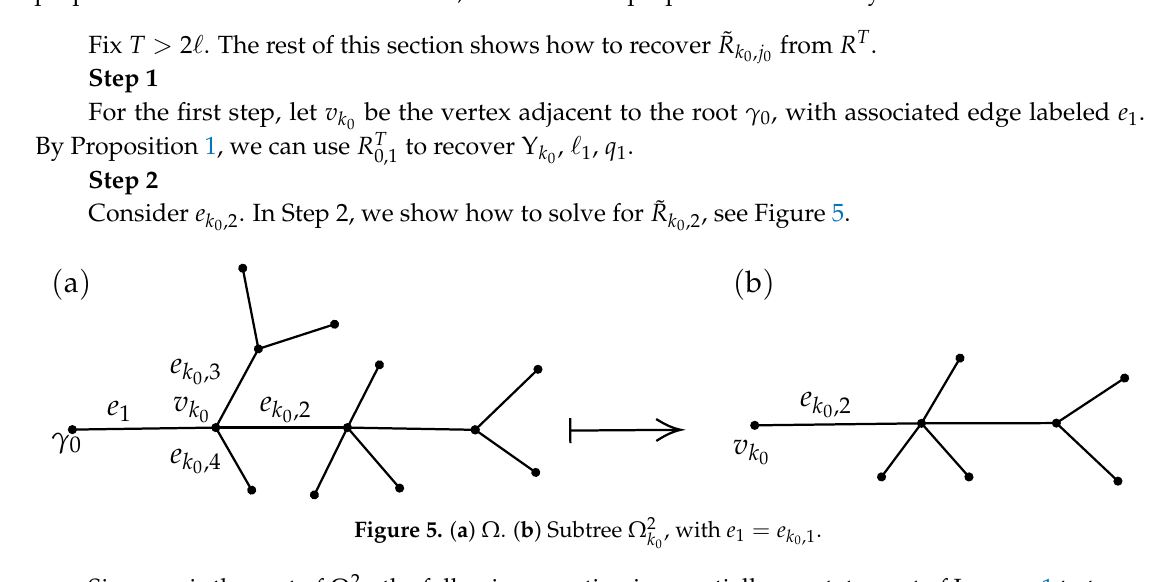
, with e 1 = e k k 0